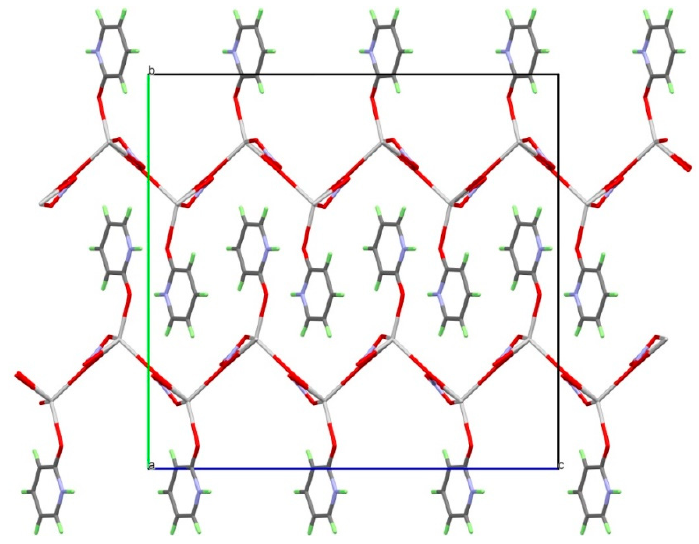
Figure 3. Projection of the structure of [Ag(2-pyridone)NO 3 ] n along the crystallographic a- axis.